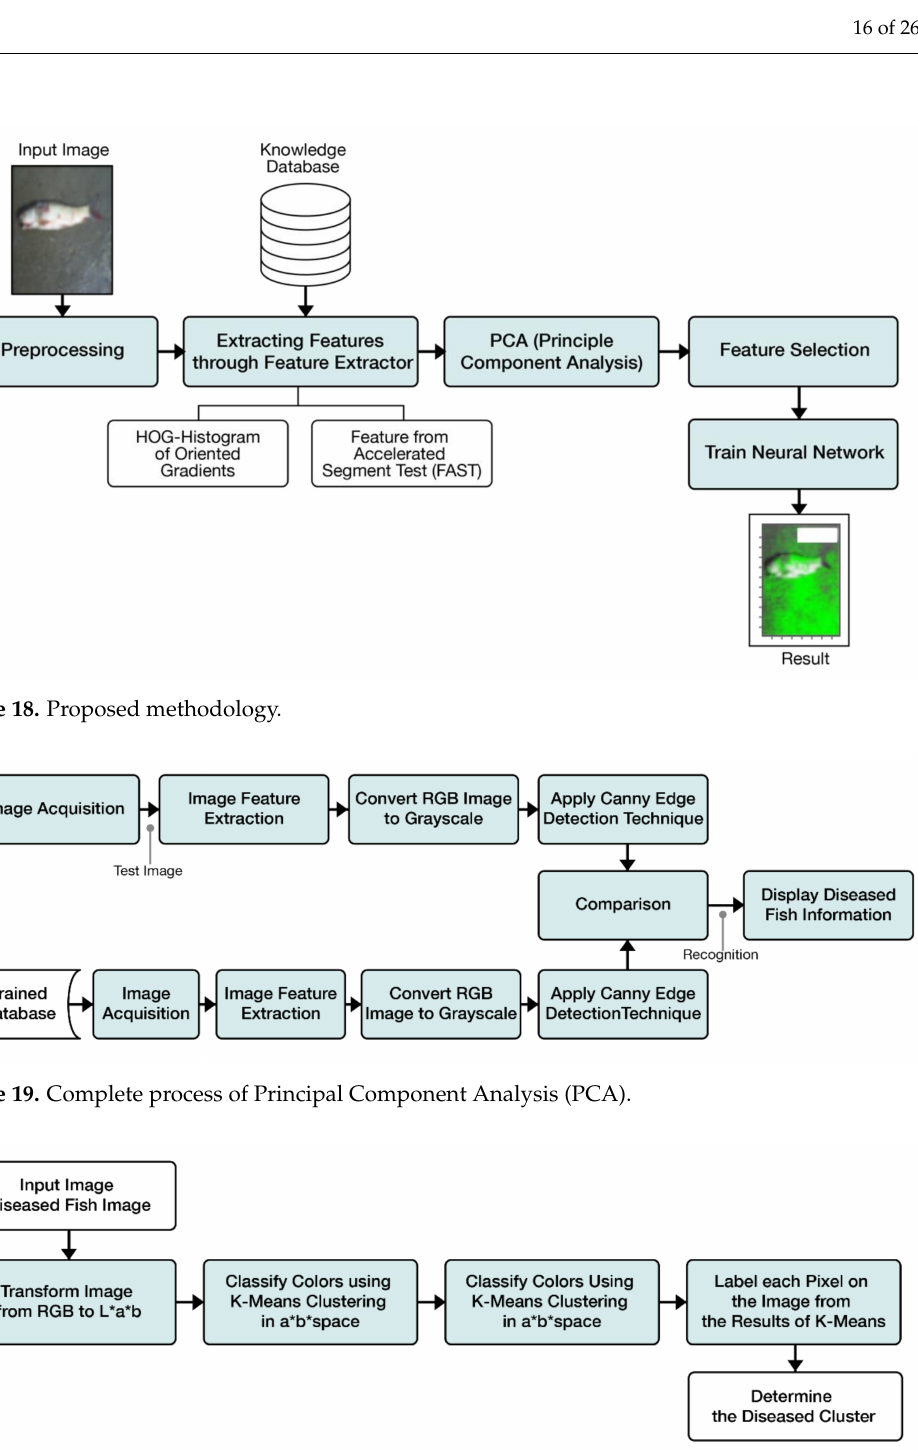
Figure 20. Complete process of K-means